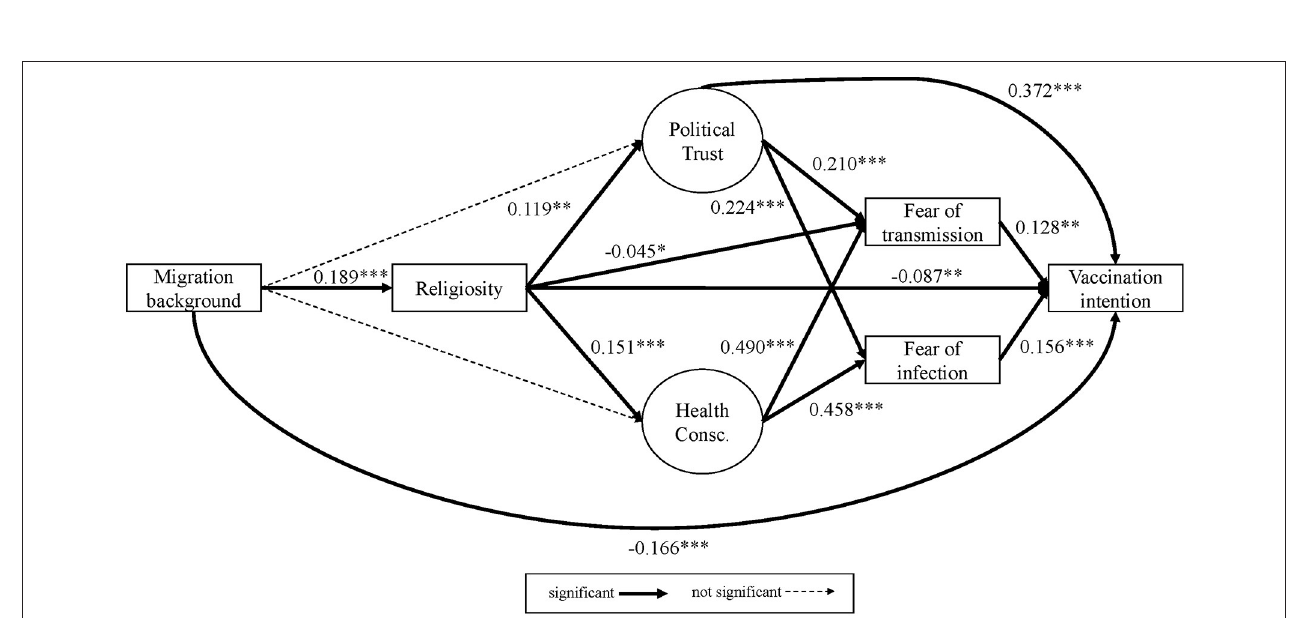
FIGURE 3 | Empirical model 1 + , all respondents (standardized) with additional paths as suggested by modification indices.